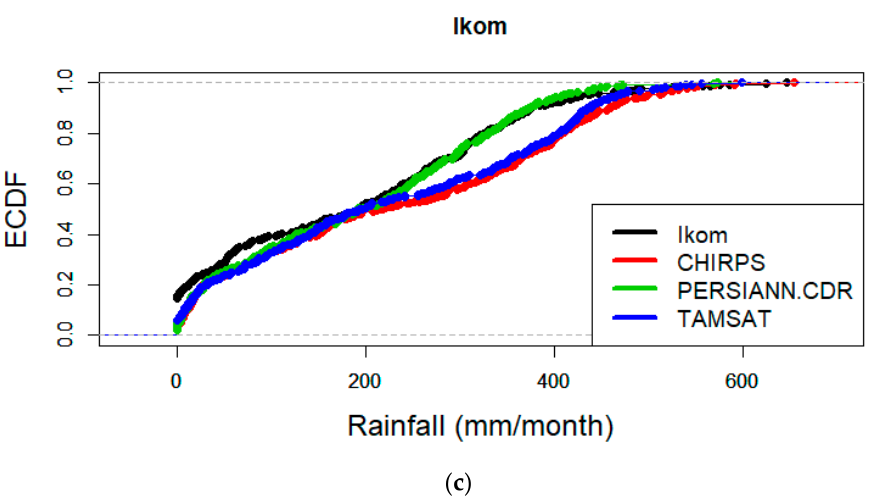
Figure 5. ( a ) Empirical cumulative distribution function (ECDF) of mean monthly rainfall in Kano Figure 5. Empirical cumulative distribution function (ECDF) of mean monthly rainfall ( a ) Kano in the within the Sahel climatic zone; ( b ) ECDF of mean monthly rainfall in Bauchi within the Savannah Sahel, ( b ) Bauchi in Savannah and ( c ) Ikom in the Guinea Coast climatic climatic zone; ( c ) ECDF of mean monthly rainfall in Ikom within the Guinea coast climatic zone.